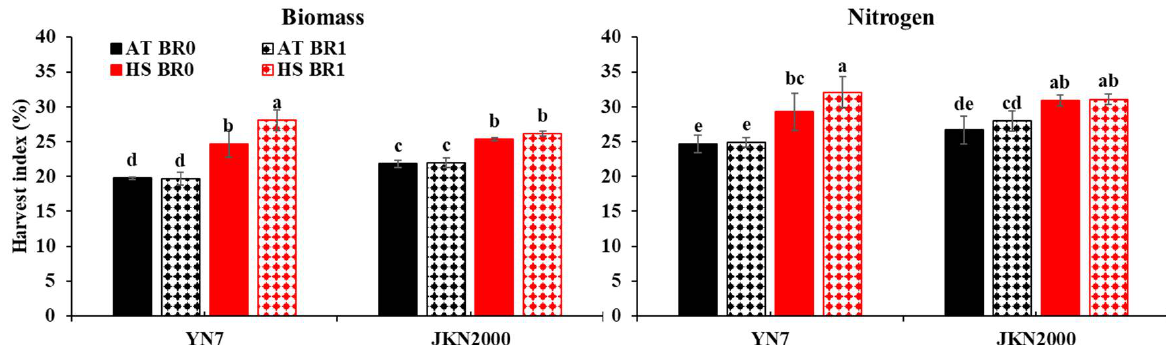
Figure 5. Effects of foliar BR application at the silking stage on harvest index of biomass and nitrogen of fresh waxy maize under post-silking ambient and high temperatures. AT, ambient temperature; HS, heat stress; BR0, application of water; BR1, application of 0.25 mg/L BR. The different letters on the column mean the difference was significant at the p < 0.05 level.